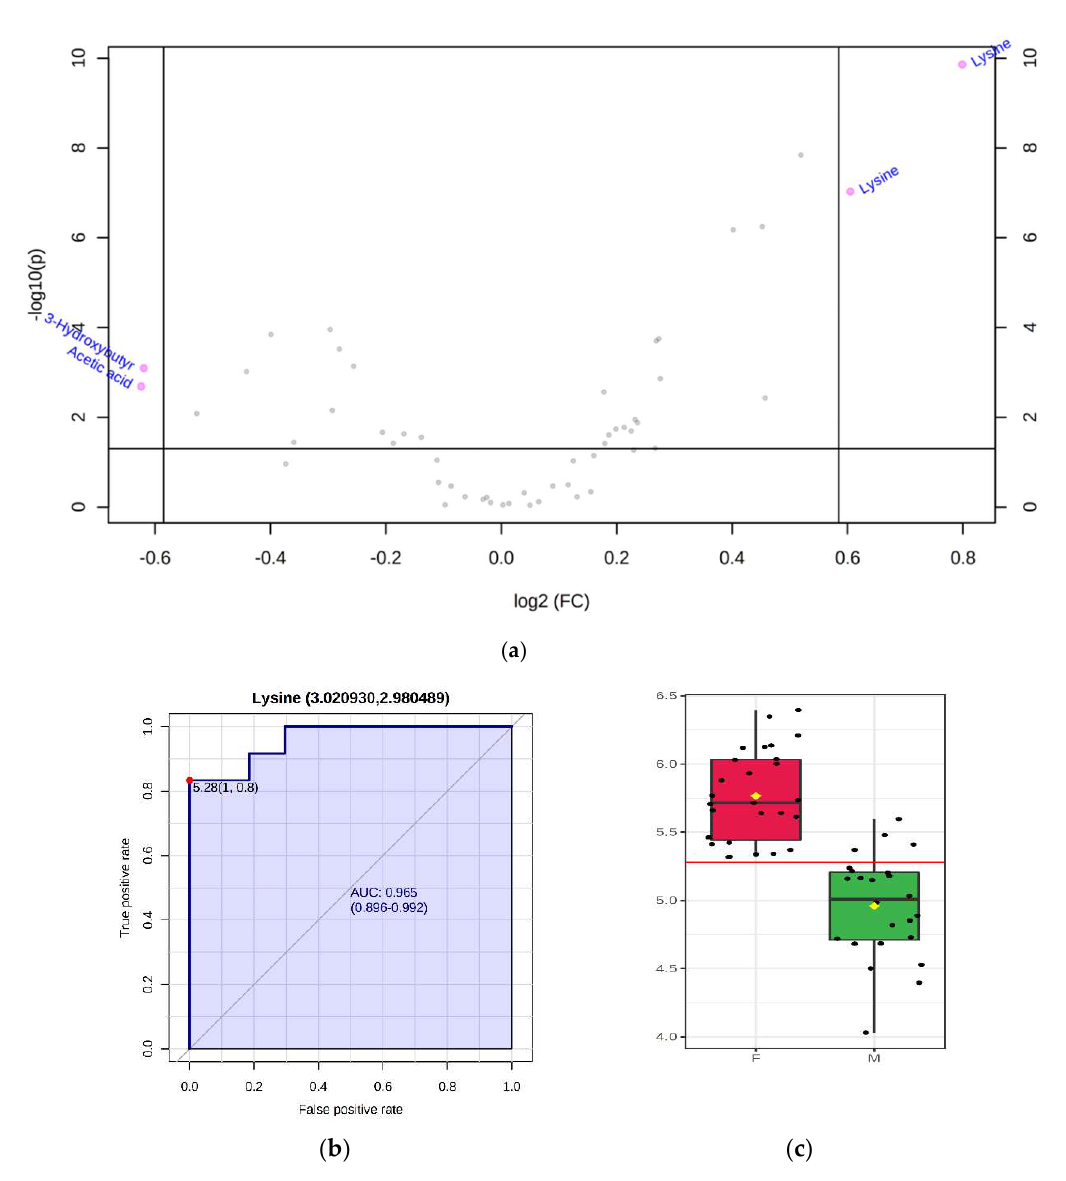
Figure 5. sPLS-DA analysis of all groups. HHF (red), HHM (green), HLF (blue), HLM (light blue), LHF (pink), LHM (yellow), LLF (purple), LLM (orange). Number of variables per component lim- ited to 10 across all, only first 2 components (% variance) illustrated. All metabolites are logarithmi- cally transformed. Indicated the discriminate clustering of male and female groups.